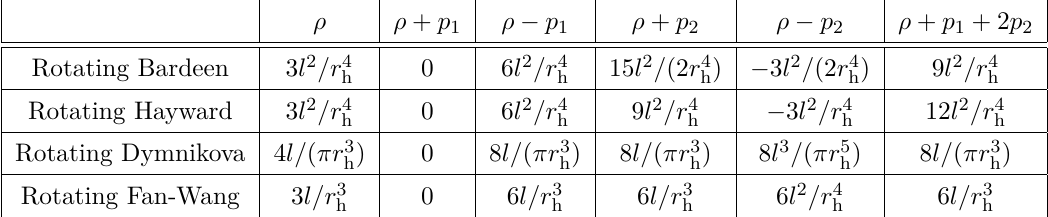
Table 6 . The leading terms in the limit r h → ∞ of the quantities in eqs. (2.43) and (2.44) evaluated on a Killing horizon r = r in the rotating non-singular black holes with l > 0 . h